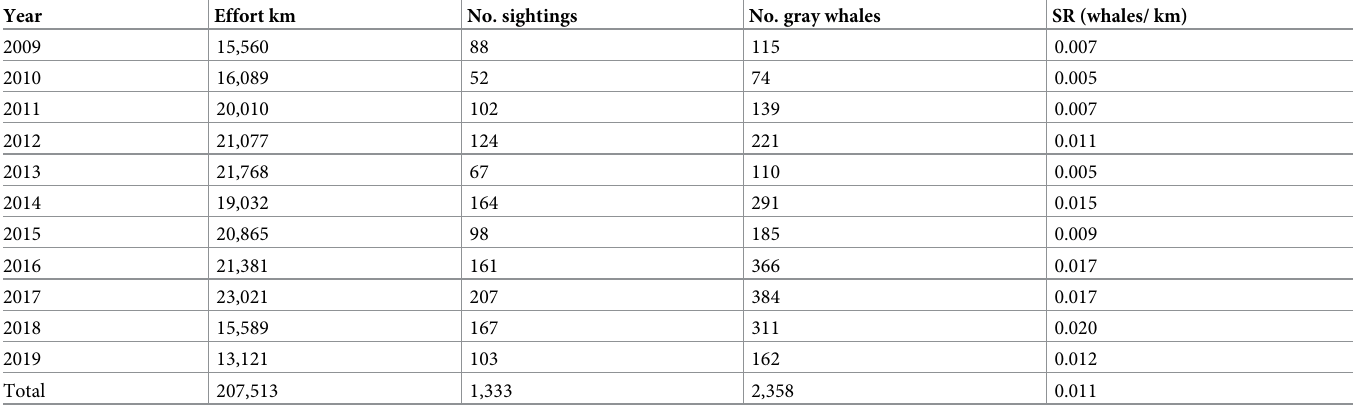
Table 1. Annual ASAMM survey effort (km), number of gray whale sightings, number of whales seen and sighting rate (SR = whale/km), July-September, 2009– 2019. Includes all sightings and effort on transect, including coastal and offshore transects, in ASAMM study